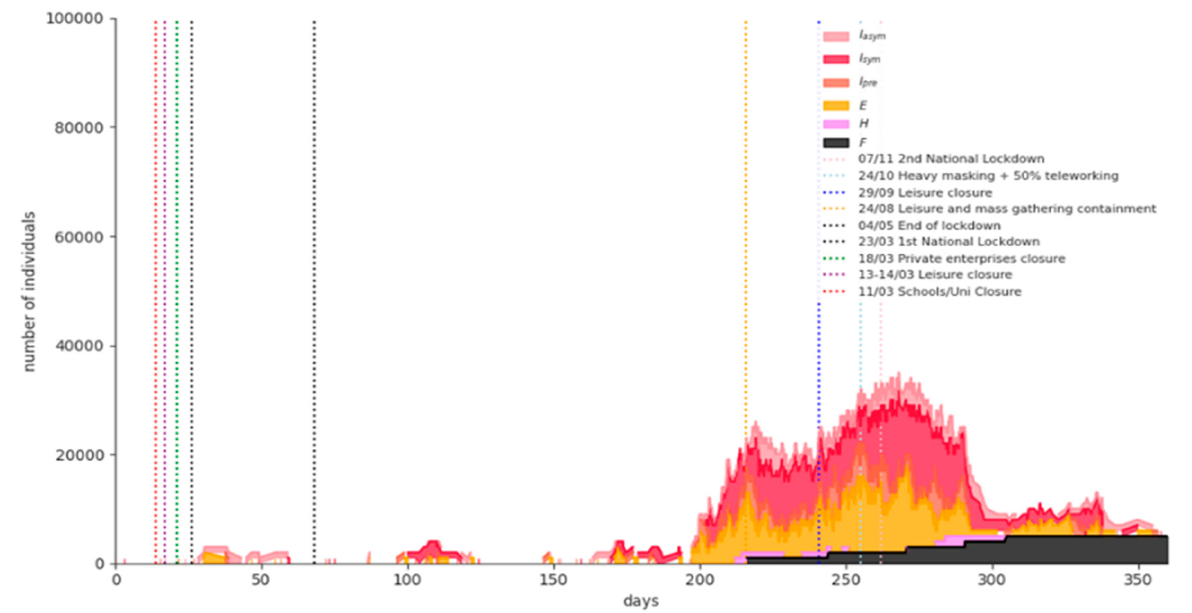
Figure 8. Simulation results for a representative Phase-1 “rolling lockdown” scenario run.